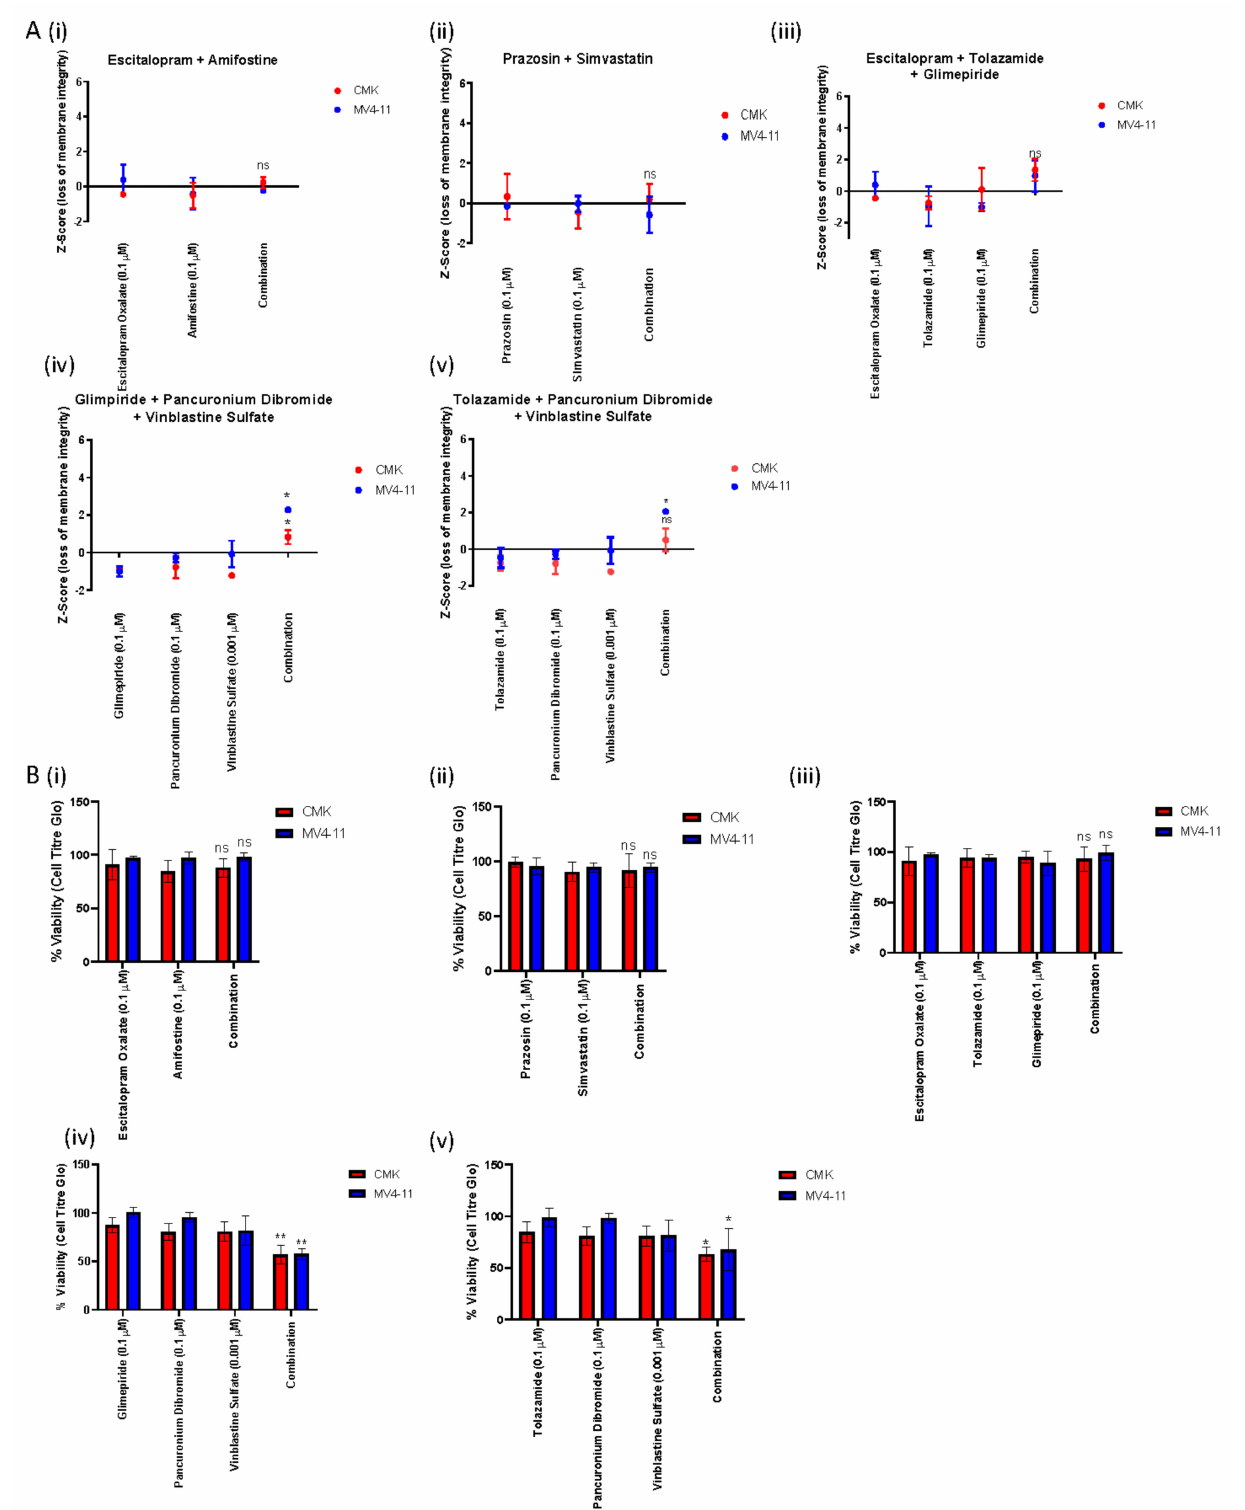
Figure 3. In vitro validation of the pairwise and triple combinations identified in the deconvolution of Plate 13 Well 115. ( A ) Loss of membrane integrity based on Z-score analysis was investigated for each of the pairwise and triple combinations identified in the secondary screen using CellTox green express cytotoxicity assay. One of the combinations was shown to cause a statistically significant increase in Z-score in both cell lines, namely A( iv ) glimepiride, pancuronium dibromide and vinblastine sulfate ( p value = 0.017128 and 0.0433105 for the CMK and MV4-11 cell lines, respectively). The combination